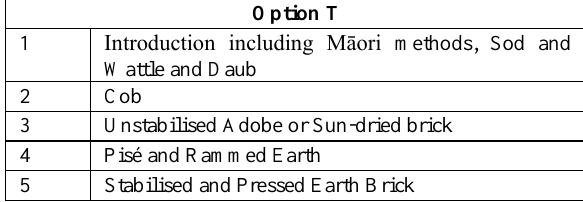
Table 5. Potential technique primary